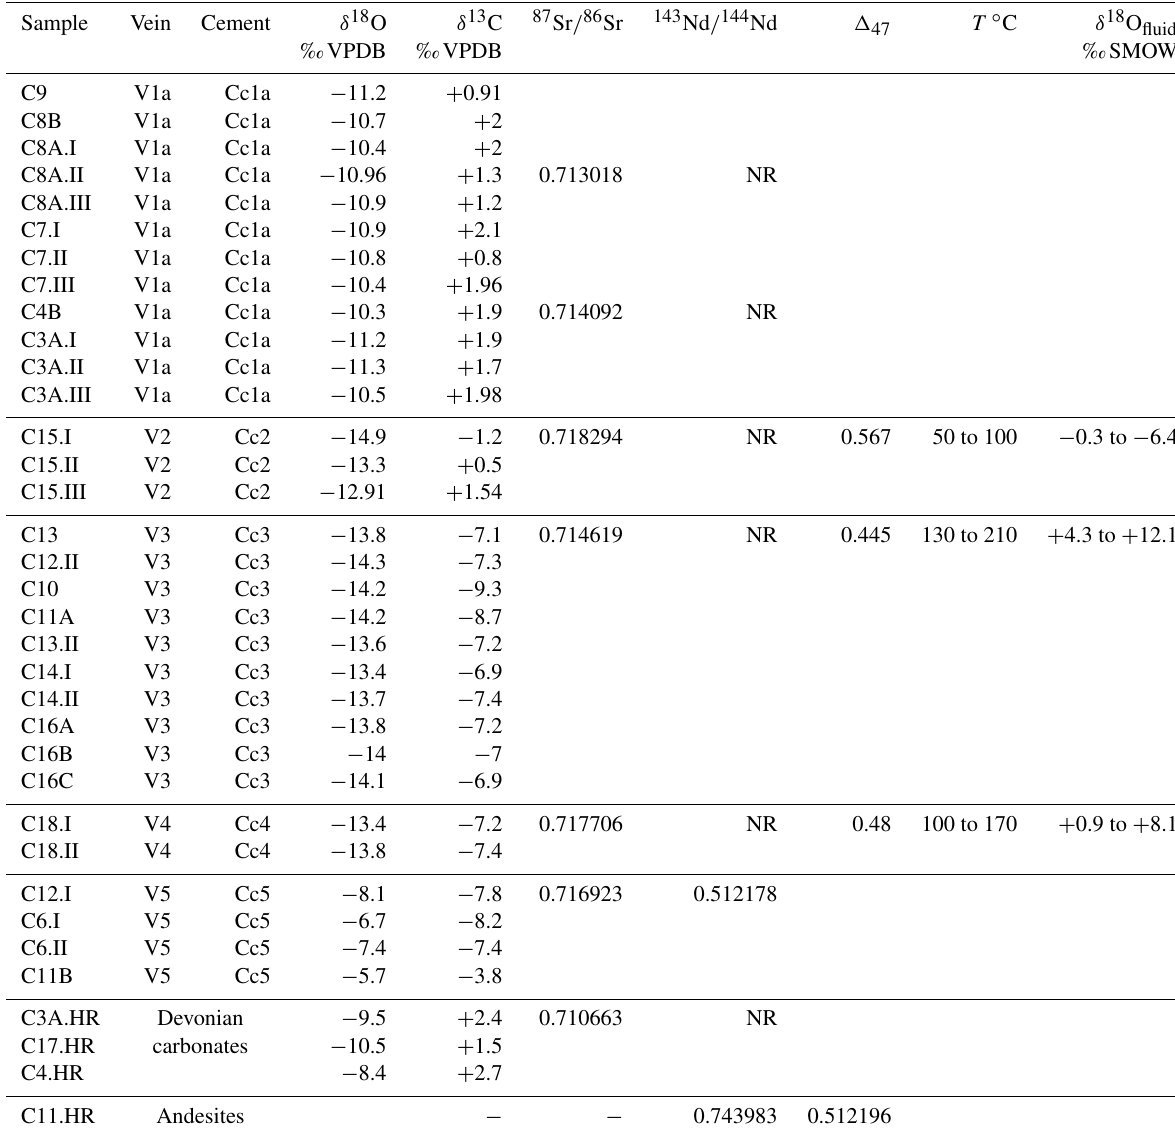
Table 1. δ 18 O, δ 13 C, 87 Sr / 86 Sr, and 143 Nd / 144 Nd ratios of the calcite cements and related host rocks. The calculated precipitation temper- ature and the δ 18 O fluid of the parent fluids are also indicated. NR indicates analyzed samples for which no result was obtained.